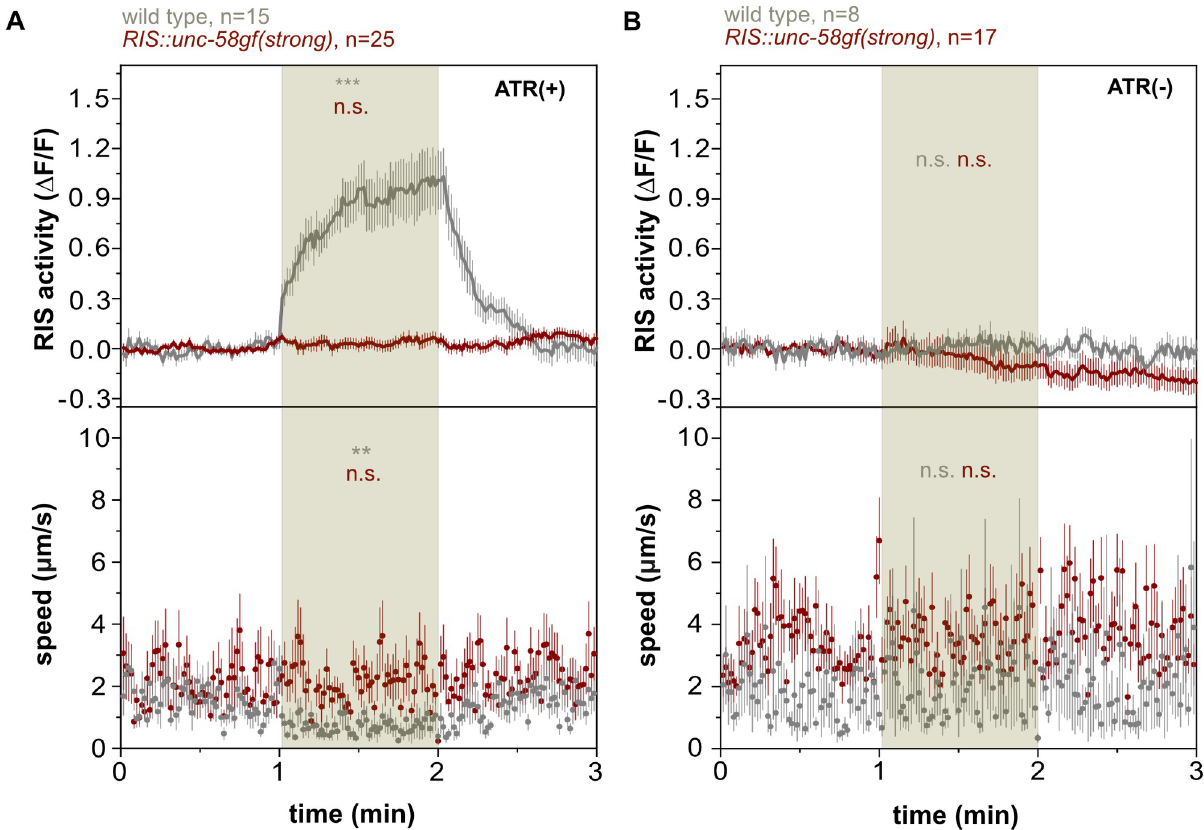
Fig 9. RIS :: unc-58gf(strong) is refractory to optogenetic activation of RIS. A) Optogenetic activation of RIS during the stimulation time (minute 1–2) leads to an increase of RIS activity and reduced mobility in wild-type worms but it does not affect the strong RIS activation strain. RIS speed was measured. A statistical comparison was made between baseline (0-1min) and stimulation (1-2min). n.s. p > 0.05, �� p < 0.01, ��� p < 0.001, Wilcoxon signed rank test. B) Control for the optogenetic experiment. Without ATR treatment, neither the wild type nor the strong RIS activation strain, shows a response to green light. N.s. p > 0.05, Wilcoxon signed rank